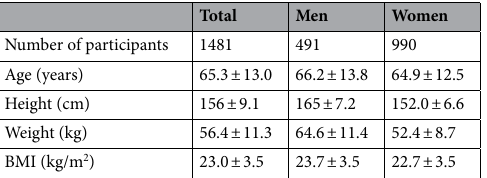
Table 1. Demographics of the participants. Values are presented as mean ± standard deviation (95% confidence intervals). BMI body mass index.